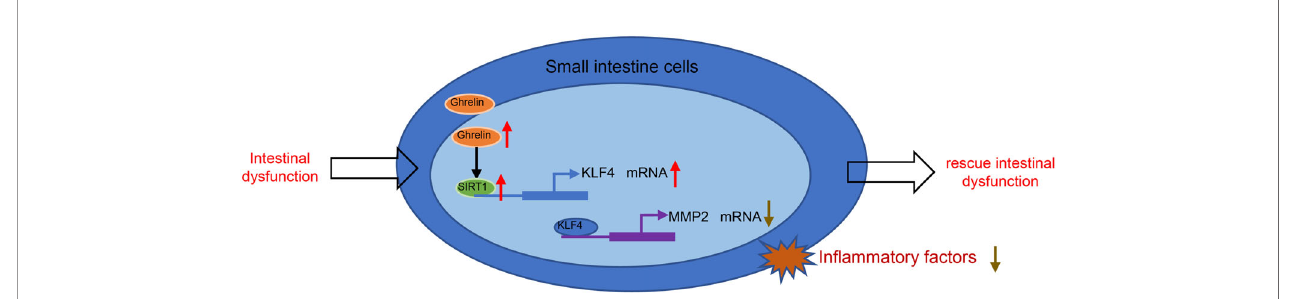
FIGURE 6 | Schematic summarizing the identi fi ed mechanism by which Ghrelin acts in sepsis-induced intestinal dysfunction. Ghrelin upregulates KLF4 expression to inhibit MMP2 level by activating SIRT1, which can alleviate the intestinal dysfunction and thereby